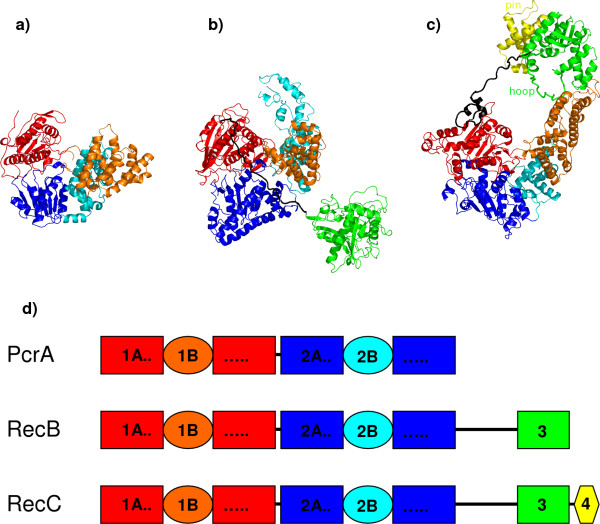
Domain comparison of PcrA, RecB and RecC. The structures of a) substrate-complexed PcrA (PDB code 3pjr; [38]), b) RecB and c) RecC (PDB code 1w36; [18]), are superimposed using domain 2A. The domains 1A are coloured red, while orange is used for 1B, blue for 2A, cyan for 2B, green for 3 and yellow for 4. The same colours are used in the schematic diagram d) which illustrates how evolution progressed through addition of domains. The "pin" and "hoop" in RecC (see text for details) are labelled. In PcrA the residues defining the starts of the various (sub-)domains are 1B, 92; 1A continuation, 218; 2A, 287; 2B, 385; 2A continuation, 553. In RecB the corresponding residue numbers are 1B, 151; 1A continuation, 349; 2A, 446; 2B, 583; 2A continuation, 729; linker, 870; 3, 900. In RecC they are 1B, 79; 1A continuation, 208; 2A, 329; 2B, 443; 2A continuation, 649; linker, 784; 3, 828; 4, 1034.